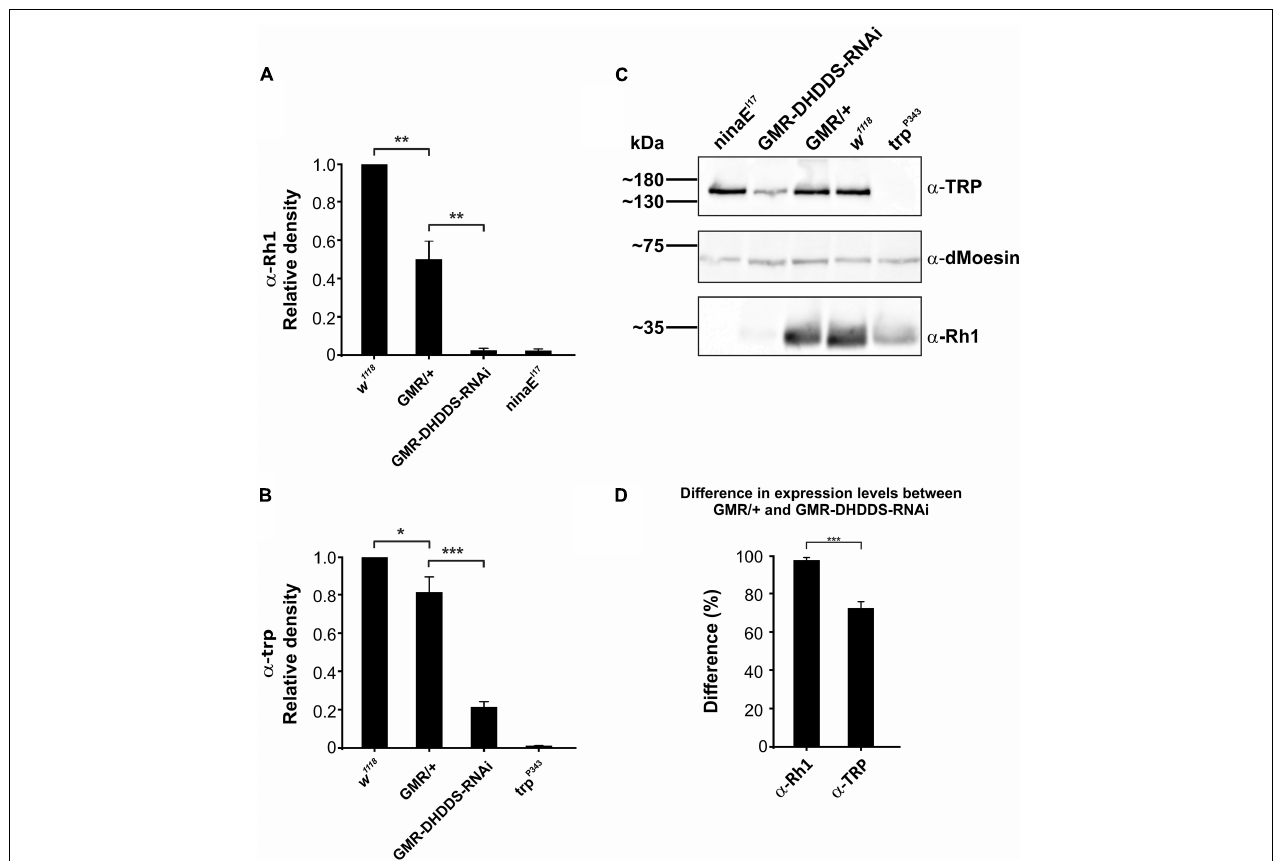
FIGURE 8 | A drastic reduction of Rh1 rhodopsin levels in GMR-DHDDS-RNAi flies. Western blot analysis that compares the expression levels of Rh1 rhodopsin and TRP channel of newly eclosed white-eyed GMR-DHDDS-RNAi fly relative to positive control of newly eclosed white-eyed w 1118 control. (A) A histogram showing a drastic reduction of Rh1 rhodopsin level in GMR-DHDDS-RNAi flies relative to positive control. The first and second columns show the Rh1 level of w 1118 and GMR/+, while the third column shows the Rh1 level of GMR-DHDDS-RNAi flies. The 4th column shows a negative control of the ninaE I 17 Rh1 null mutant. For each group, the histogram shows the average value of normalized α Rh1 denseties from all experiments, relative to the control ( w 1118 ) group. Statistical analysis was done using the Student’s t -test, in a two-tailed paired test. Data is presented as mean ± standard error of the mean (SEM), n = 6 or 7 for each group. A significant (* P ≤ 0.05) difference in α Rh1 densities was found between the GMR/+ and w 1118 groups, and between the GMR-DHDDS-RNAi and the GMR/+ groups. (B) A histogram showing a reduction of TRP channel protein level in GMR-DHDDS-RNAi flies relative to the positive control. The first and second columns show TRP level of w 1118 and GMR/+ of the same flies used in section (A) , while the third column shows the TRP level of GMR-DHDDS-RNAi flies. The 4th column shows a negative control of the trp P 343 a TRP null mutant. For each group, the histogram shows the average value of normalized α -TRP denseties from all experiments, relative to the control ( w 1118 ) group. Statistical analysis was done using the Student’s t-test, in a two-tailed paired test. Data is presented as mean ± standard error of the mean (SEM), n = 6 or 7 for each group. A significant (* P ≤ 0.05) difference in α -TRP densities was found between the GMR/WT and WT groups, and between the GMR-DHDDS-RNAi and GMR/WT groups (*** P ≤ 0.001). (C) A representative Western blot showing an example of a blot used in the histograms. Heads or eyes were lysed and run on gel. Following the protein transfer from the gel to a PVDF membrane, we dissected the membrane into three sections. Each section was probed with a different antibody: α Rh1 (monoclonal, 1:1,000 dilution), α TRP (polyclonal, 1:1000 dilution), and α -dMoesin (polyclonal, 1:10,000 dilution). The density of the α -Rh1 and α -TRP bands were corrected by the dMoesin signal serving as a protein loading control, and calculated as a percentage of control fly ( w 1118 ) signals. (D) A histogram showing the difference between Rh1 rhodopsin and TRP channel protein levels in the GMR-DHDDS-RNAi flies, and their levels in the GMR/+ flies. For each target protein (Rh1 rhodopsin or TRP channel) the mean difference between expression levels in the GMR/+ flies and expression levels in the